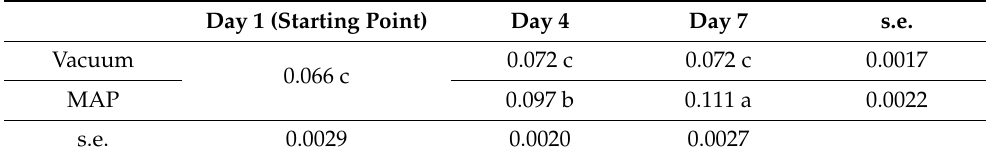
Table 2. The means and standard error (s.e.) for lipid oxidation (mg MDA/g) as a function of packaging type and storage time.